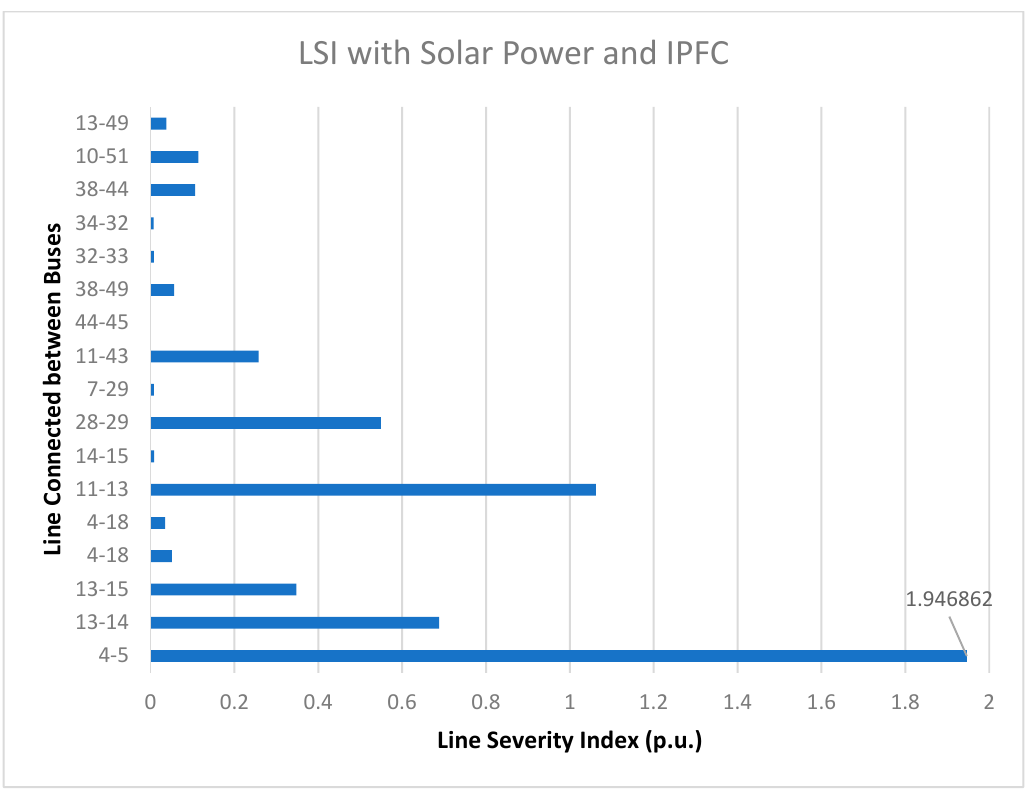
Figure 11. Line Severity Index for various contingency conditions.